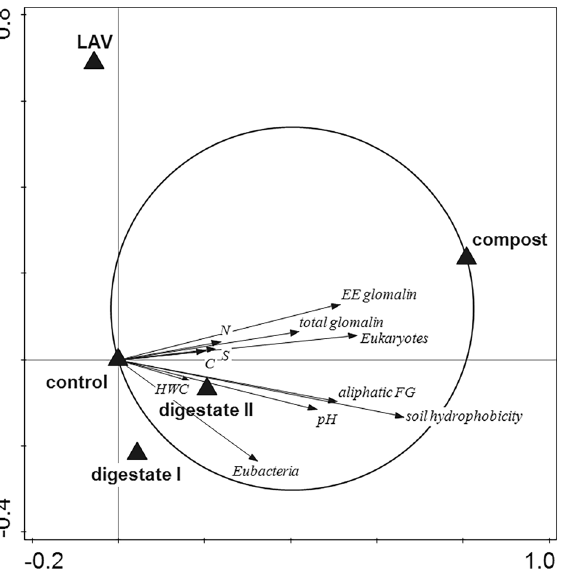
Figure 3. T-value biplot for the relationships between the soil parameters and the compost application. The arrows fully falling within a Van Dobben circle indicate a significant positive ( P < 0.05) relationship between a soil parameter and the predictor. Soil parameters located outside the circles are not displayed, although they were included in the analysis. Functional groups (FG); hot water extractable carbon (HWC); easily extractable glomalins (EE glomalin); SOC (soil organic carbon)